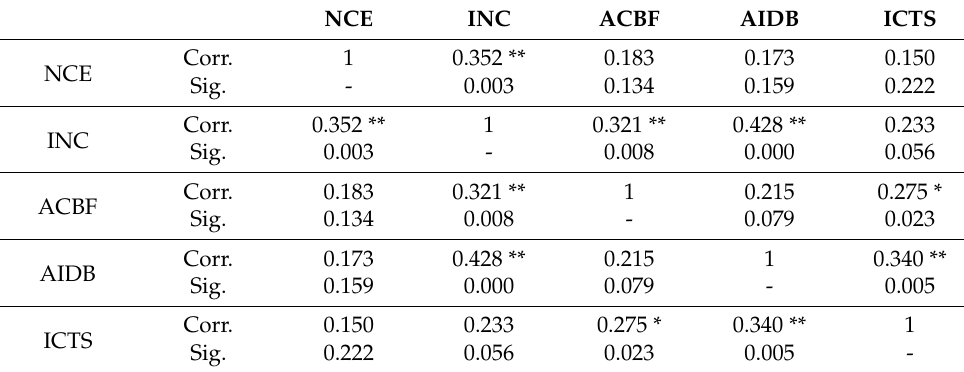
Table 3. Correlations between ICT indicators.